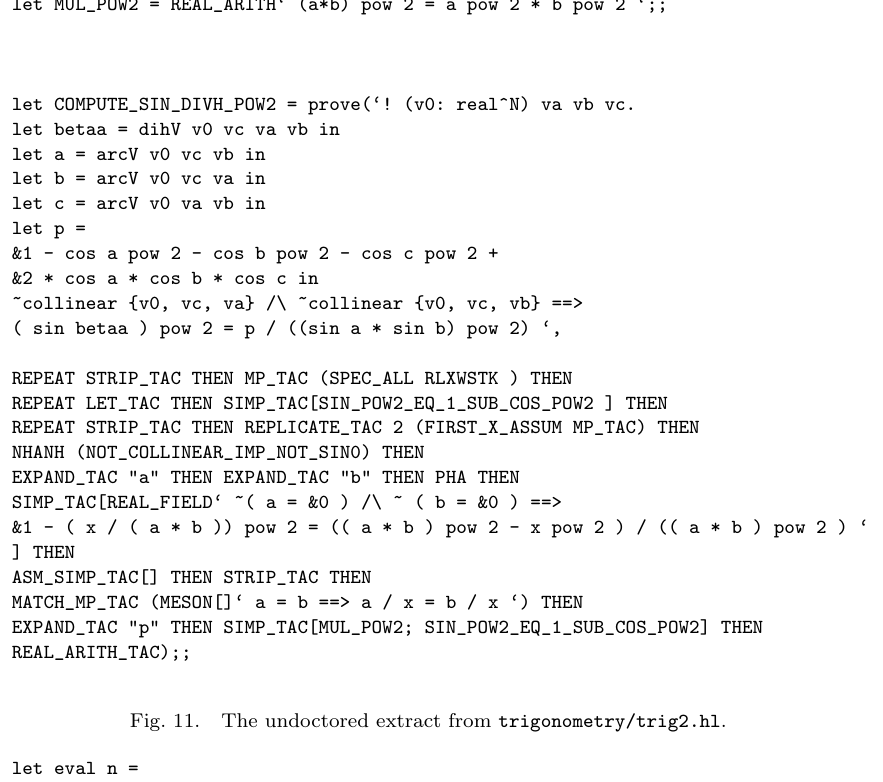
Fig. 12. The eval function from general/update database 310.ml